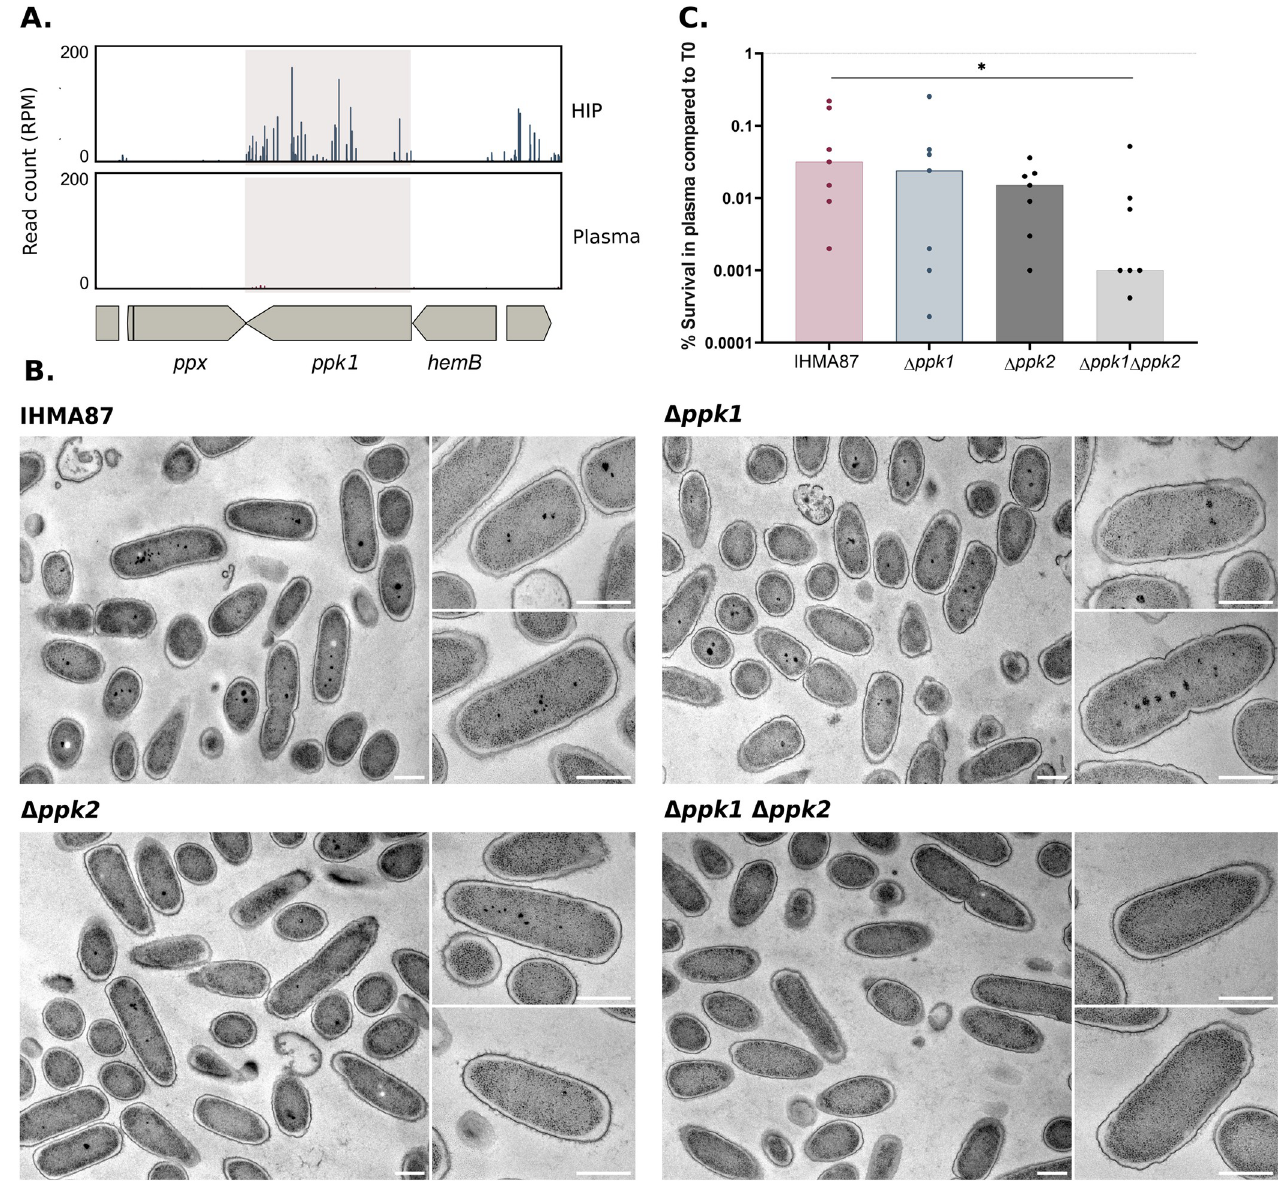
Fig 6. Polyphosphates are critical for evaders’ survival in plasma. A. Zoom in on Tn-seq profiles of ppk1 gene with 2000 bp upstream and downstream, showing normalized numbers of reads in input (HIP) and output (plasma) samples. B. Transmission electron microscopy images of IHMA87, Δ ppk1 , Δ ppk2 or Δ ppk1 Δ ppk2 after 1h-incubation in human plasma. Scale bar = 500 nm. C. Survival of IHMA87 wild-type strain, individual Δ ppk1 , Δ ppk2 or double Δ ppk1 Δ ppk2 deletion mutants following incubation for 3 h in plasma. Survival rates were calculated based on CFU measurements and the median of all independent experiments is represented by the histogram. Statistical analysis was performed and p -value < 0.05 is indicated with ‘ � ’.